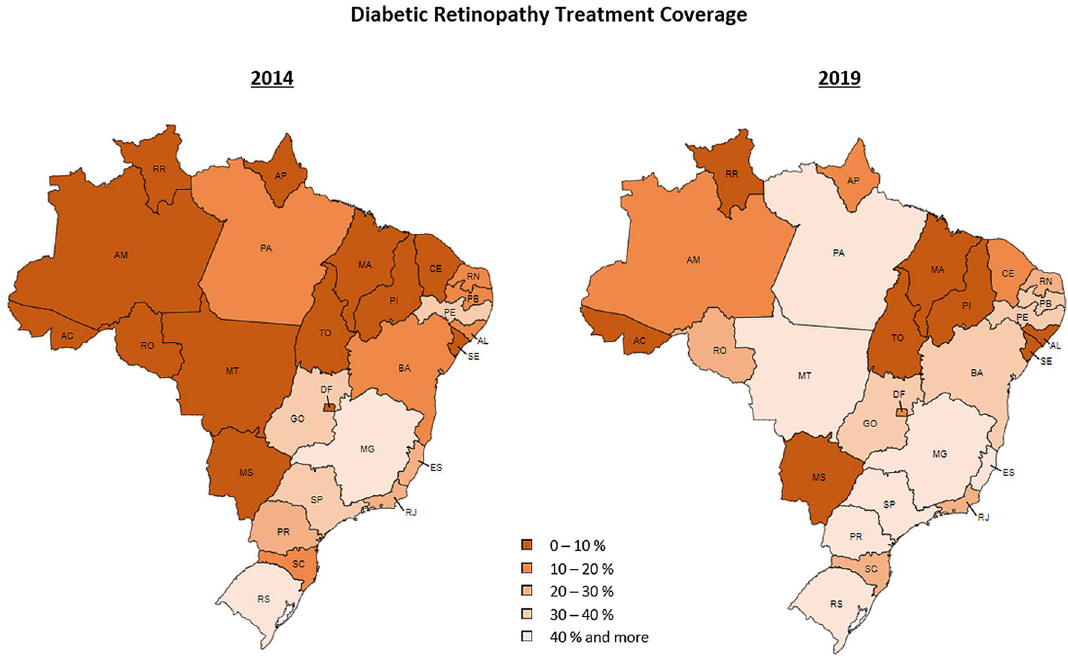
Figure 3. Diabetic Retinopathy Treatment Coverage among Diabetic Patients through SUS in 2014 and 2019, by state. Source: